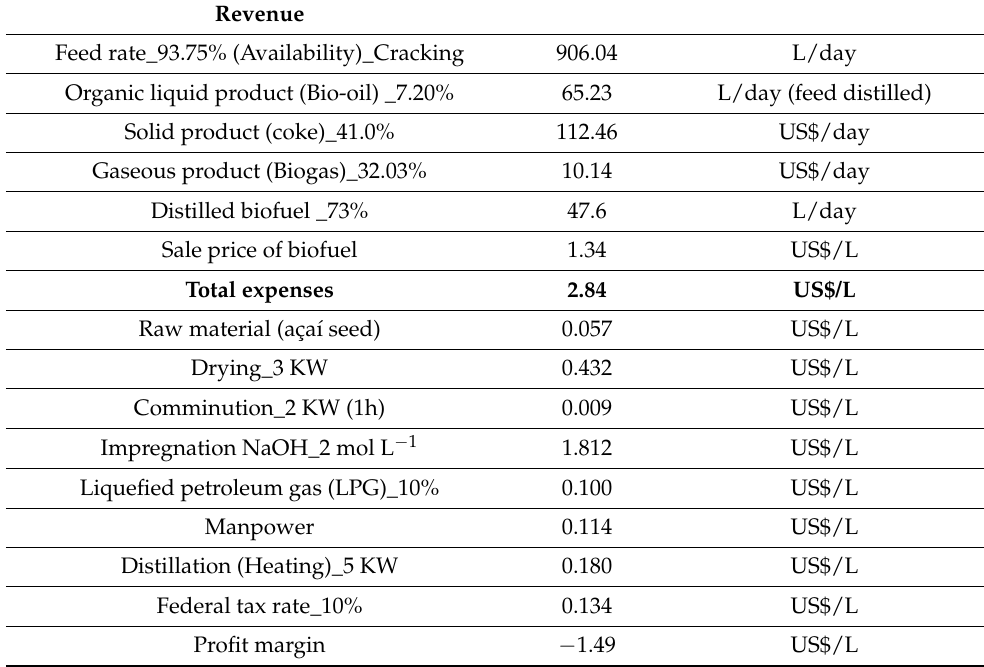
Table 7. Revenues and expenses by pyrolysis of aça í seeds ( Euterpe oleracea Mart.) in nature to produce